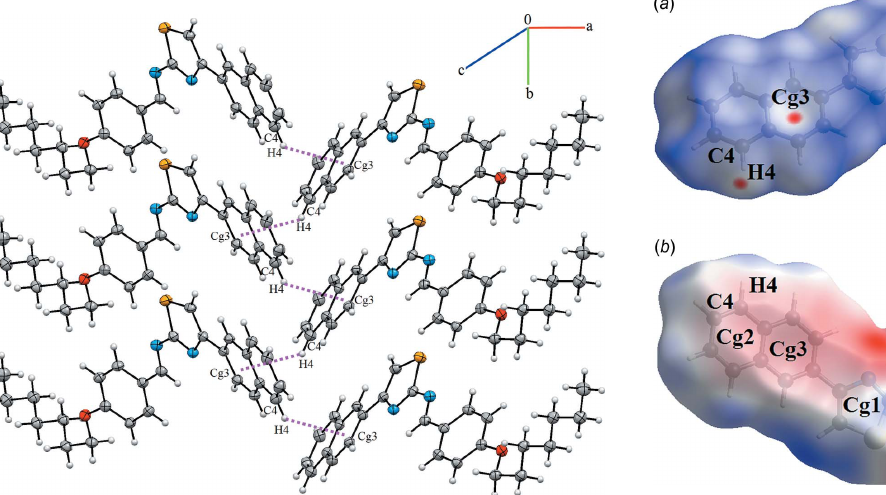
Figure 2 Aview of the crystal packing of the title compound. The C—H (cid:3)(cid:3)(cid:3) (cid:2) (ring) interactions are indicated by dashed lines.